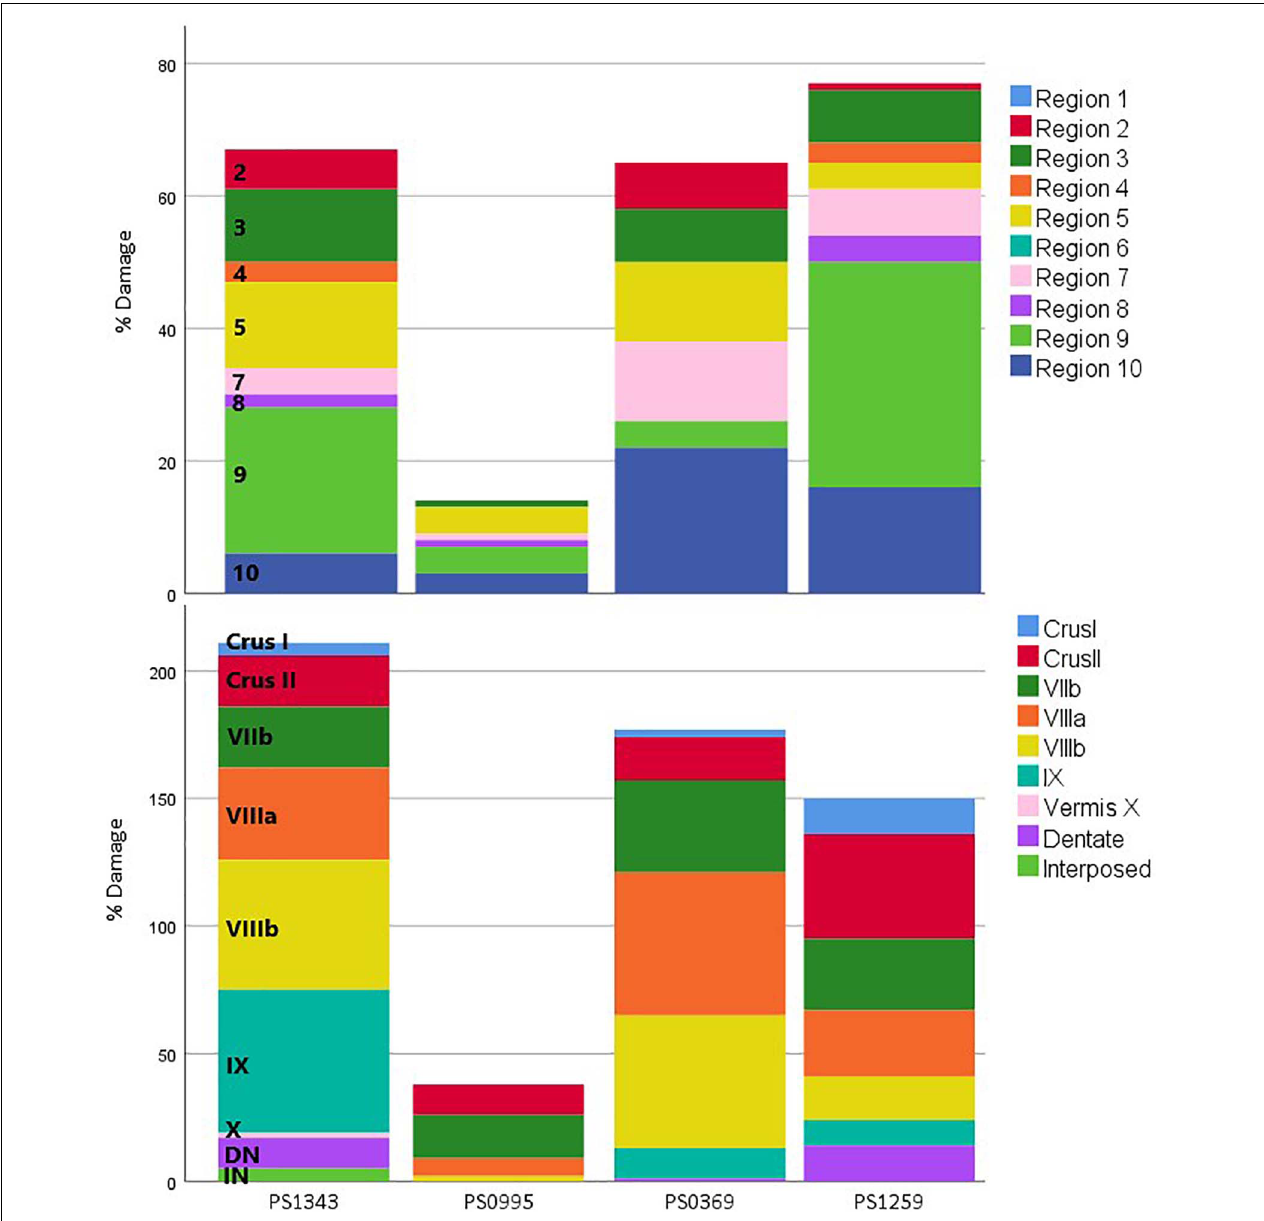
FIGURE 2 | Percent damage to each region for each patient. Percent damage to functional (top; King et al., 2019) and anatomical (bottom; Diedrichsen, 2006) regions. The size of each colored section represents the percent of damage to that region. This allows comparing the damage to each region between the patients. Regions not damaged in any of the patients are not included in this figure. DN, Dentate Nucleus; IN, Interposed Nucleus.